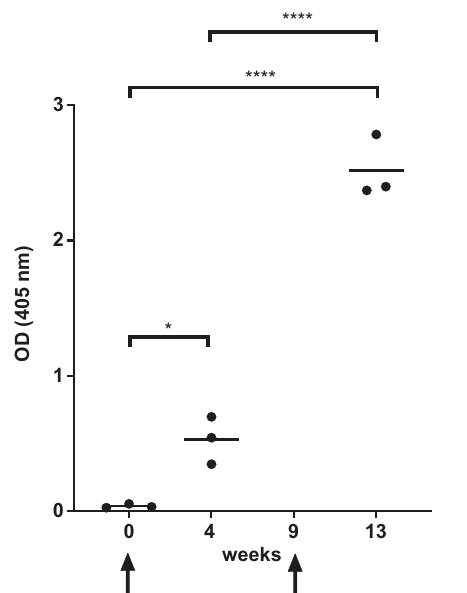
Fig. 6 HIV-enhanced humoral immune responses by IONAID boost in non-human primates (NHP). HIV gp140 IgG responses from immunized animals ( n = 3) after intramuscular vaccination with 1.10 8 TCID 50 rVSV-B6-NL4.3Env/Ebotm and boost with 1 mg of pIDV-II-HIVenvNL4.3/Ebotm and 0.3 mg of pIDV-II-revNL4.3 using IONAID. Antibodies responses were analyzed by ELISA at day 0, 4 weeks after vaccination and 4 weeks after boost from serum samples, which were used in a 1/200 dilution. The horizontal line represents the mean of all animals. Statistical analysis was made using one-way ANOVA, followed by Tukey multiple comparisons test. Asterisks denote statistically signi fi cant data (* P <